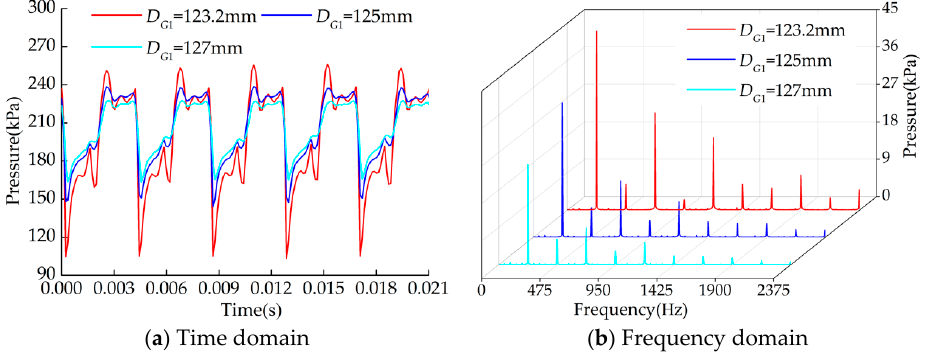
Figure 23. Frequency response curves of pressure inside the impeller with different inlet diameters of